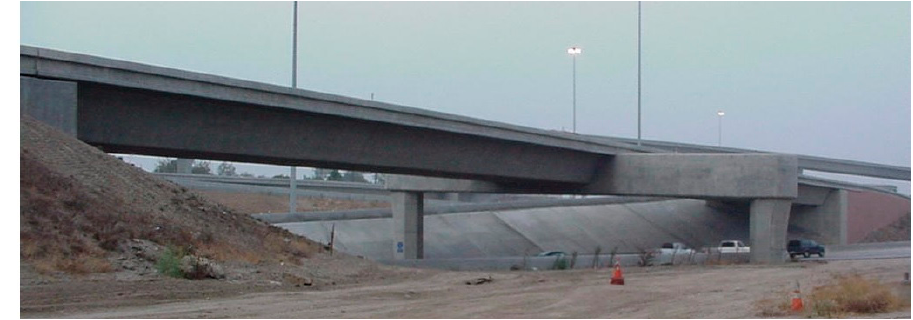
Figure 1. The benchmark highway bridge.